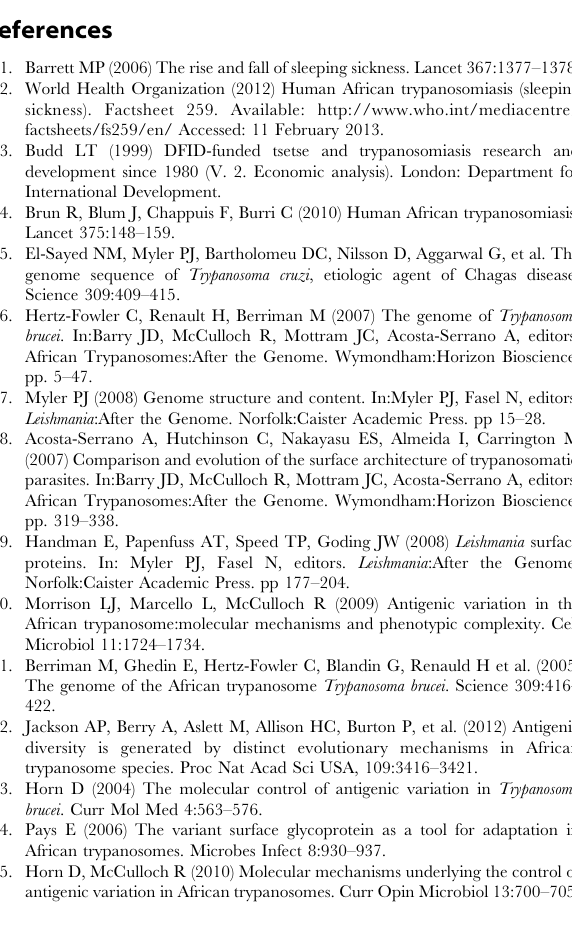
Table S1 Gene families comprising the cell surface